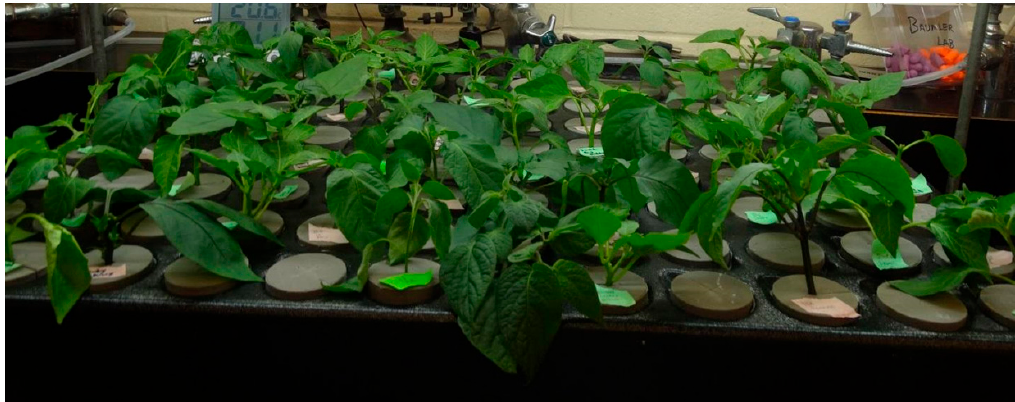
Figure 1. Capsicum spp. cuttings in aeroponic cloning machine.